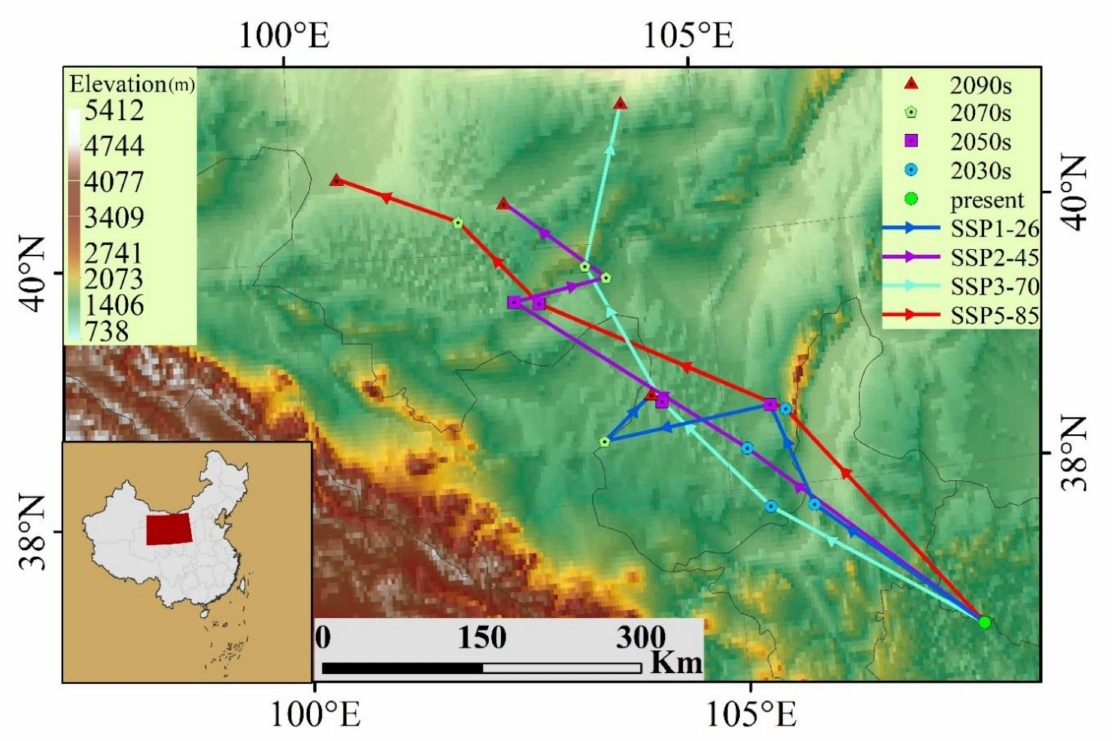
Figure 7. Suitable area shifts (based on the centroid of suitable distribution map) of Valsa mali in four climate scenarios (the Shared Socioeconomic Pathways (SSP) 1–26, SSP2–45, SSP3–70, and